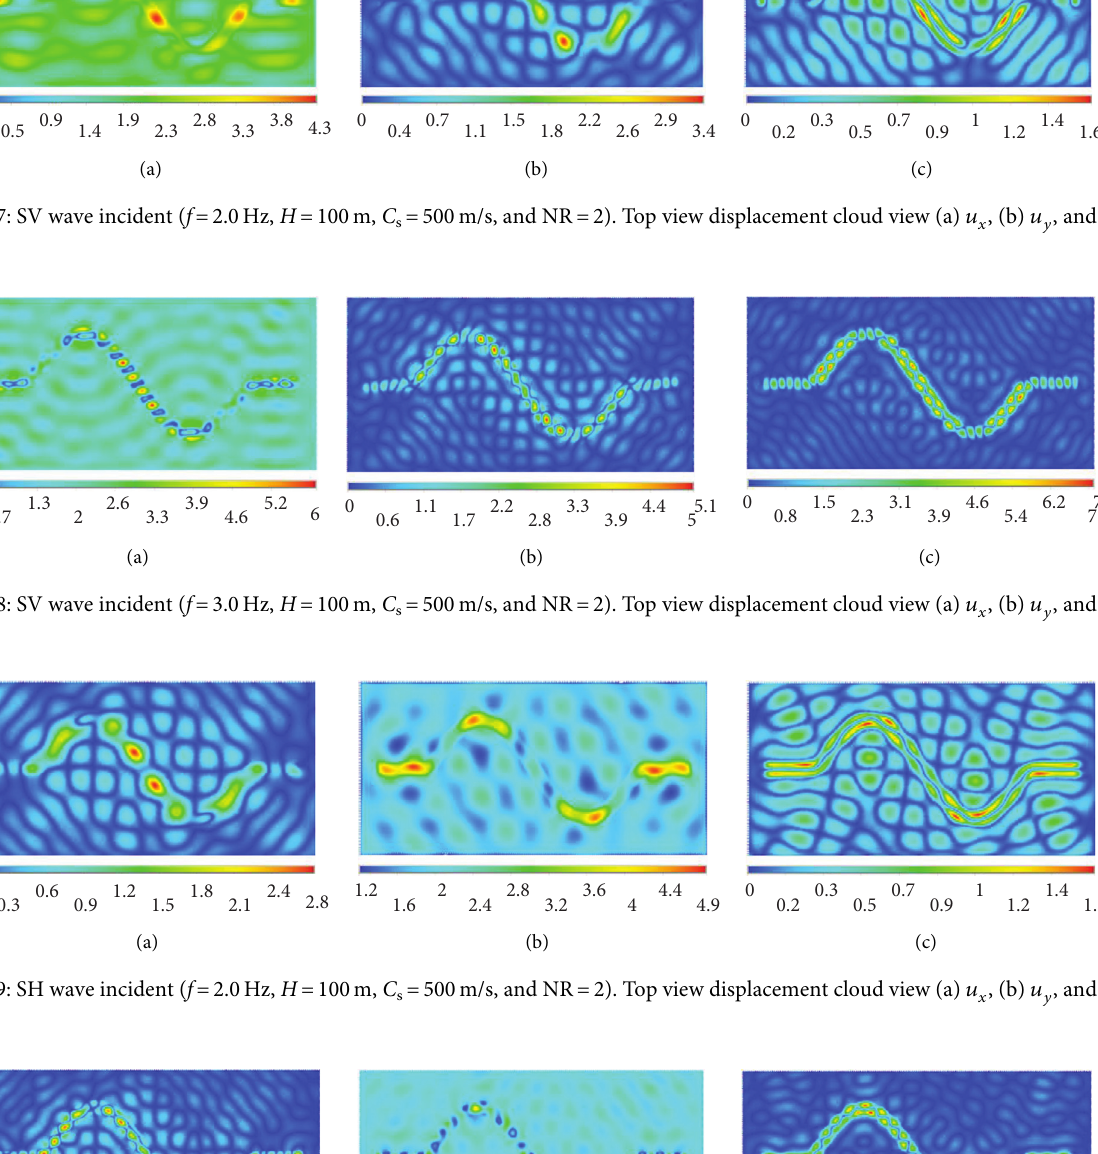
� 500m/s, and NR � 2). Top view displacement cloud view (a) u s